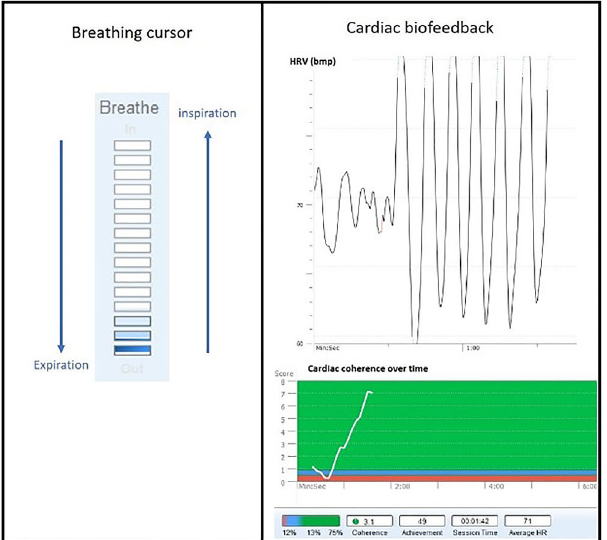
Figure 2. Coping interventions. Breathing cursor (left part) and cardiac biofeedback visual interface (right part). The visual cursor driving the inspiration and expiration at 6 breaths/min. The visual biofeedback gave information on instantaneous heart rate (beats/min) and scores of cardiac coherence (emWavePRO® interface, HeartMath technologies, Add